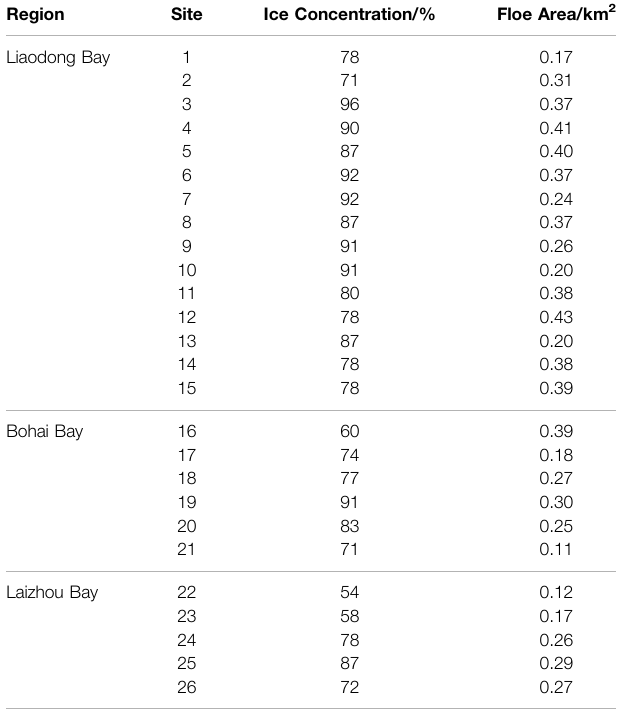
TABLE 2 | Design index of ice concentration and fl oe area at the 26